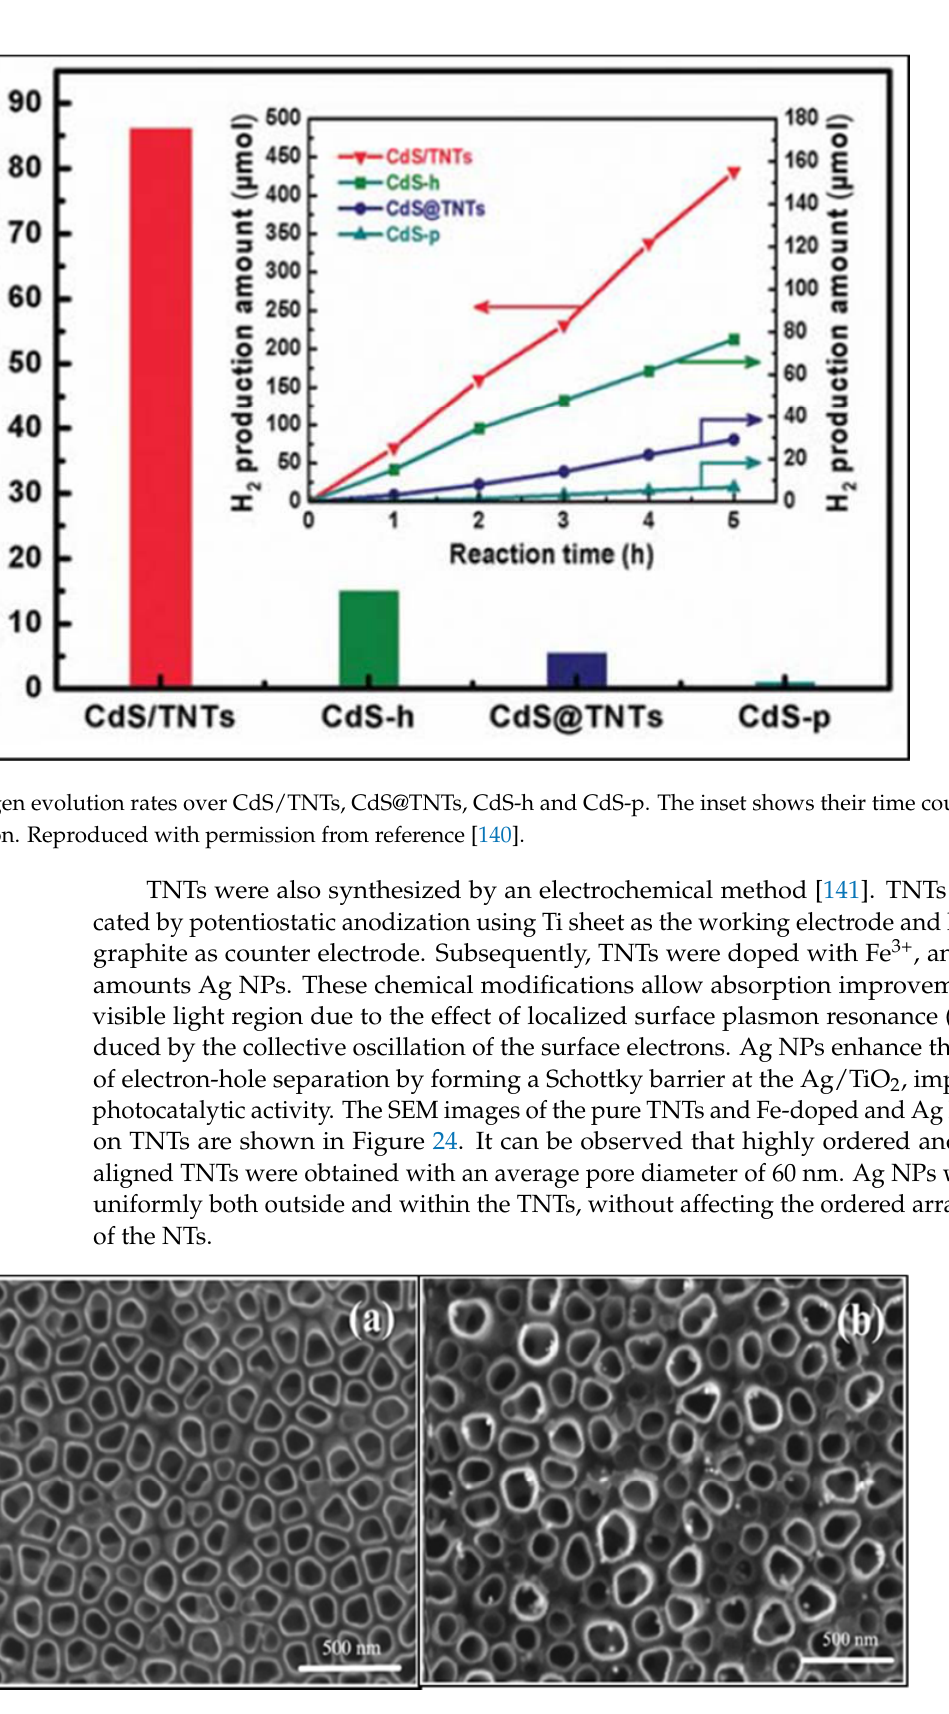
Figure 24. SEM images: ( a ) pure TiO 2 NTs, ( b )Fe doped and Ag NPs loaded on TiO 2 NT. Reproduced with permission from reference [141].